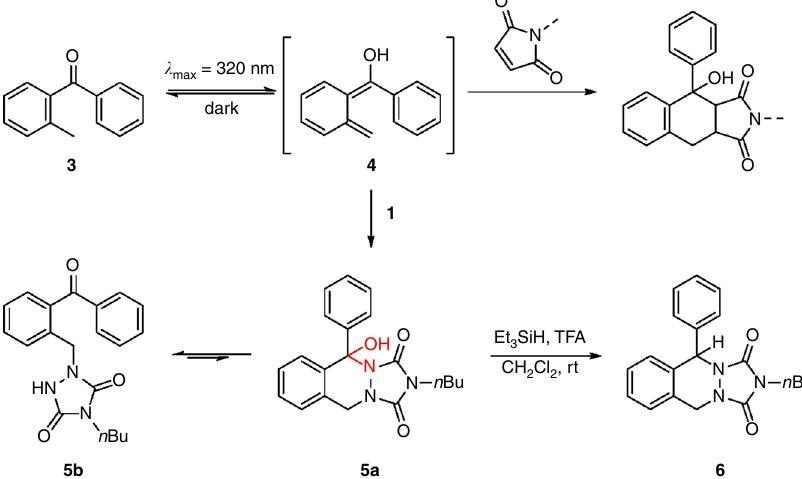
Fig. 4 UV-induced photoenol reaction of o -methylbenzophenone. Photoisomerization of o -methylbenzophenone 3 generates diene 4 that is susceptible toward [4+2] -cycloaddition reactions with electron poor enes such as N -maleimides. Reaction of 4 with 4- n -butyl-TAD 1 leads to a mixture of 5a and 5b , with both products shown to stand in equilibrium with one another via the labile hemiaminal type bond (highlighted in red), as was evidenced by the formation of cyclic adduct 6 upon